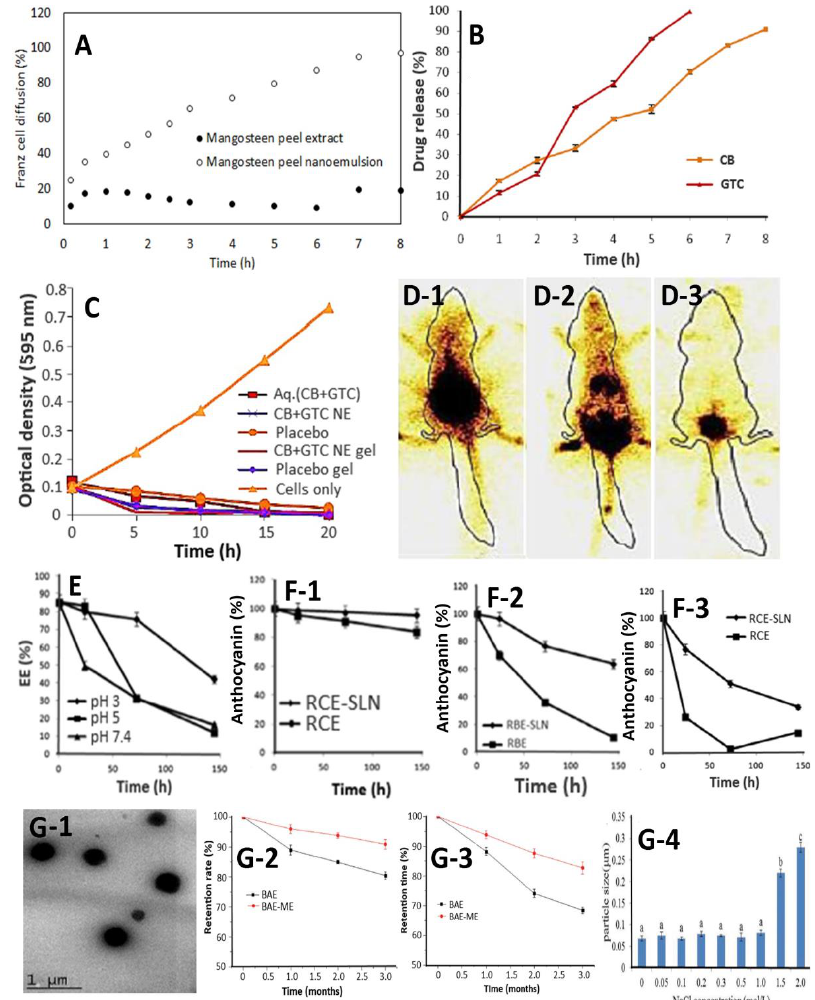
Figure 3. In vitro and in vivo evaluation of anthocyanin nanoemulsion prepared from several natural fruit / vegetable extracts. Panel ( A ), Anthocyanin nanoemulsion from mangosteen peel showing higher di ff usion in in vitro Franz cell di ff usion test than extract (topical skin application). Panel ( B ), cranberry and green tea catechin extracts nanoemulsion gel (CB + GTC NE gel) showing high in vitro release of CB and GTC into simulated vaginal fluid. Panel ( C ), CB + GTC NE gel showing faster growth inhibition of Escherichia coli compared to other treatments. Panel ( D1–3 ), Gamma scintigraphy images of female Sprague-Dawley rats after oral ( D1 ) and intravaginal ( D2 ) administration of radiolabeled CB + GTC NE gel ( 99m Tc-CB / GTC-NE gel) as well as intravaginal administration of radiolabeled CB + GTC aqueous mixture ( 99m Tc-Aq.CB + GTC) ( D3 ). Panels ( E ) and ( F1–3 ), stability of red cabbage anthocyanin-based solid-lipid nanoparticles (RCE-SLN) as a ff ected by di ff erent pH (E) and temperatures at 25 ◦ C (F1), 45 ◦ C (F2), and 60 ◦ C (F3) during storage for six days. Panel G1-4, TEM image (G1) of anthocyanin microemulsion prepared from blueberry extract (BAE-ME) along with its stability as a ff ected by storage over a three month period at 4 ◦ C (G2) and 25 ◦ C (G3) as well as di ff erent ionic strengths (G4) (adapted with permission from references